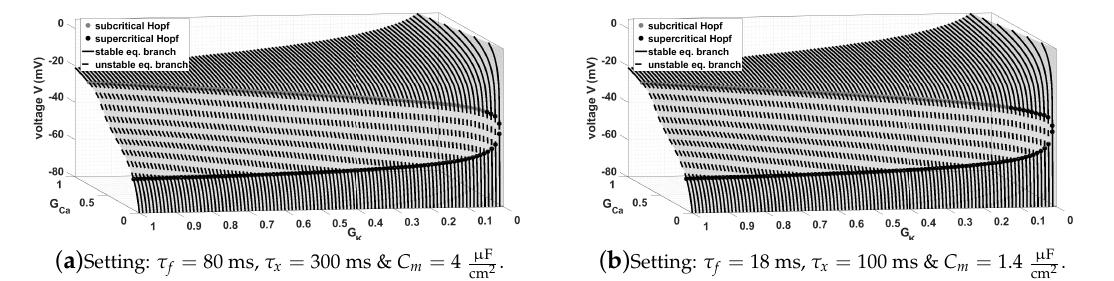
Figure 8. 2-bifurcation problem: equilibrium curves of (1) for different settings showing the shape of the equilibrium curves remain the same but the behaviour of the curves is depending on the choices of the parameters τ f , τ x and C m